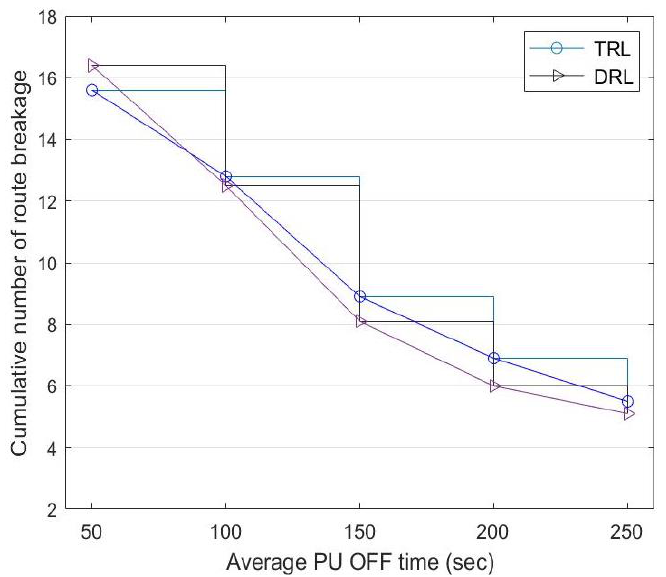
Figure 12. Cumulative number of route breakages between TRL with α = 0.5 and the DRL mechanism at a different PU-OFF